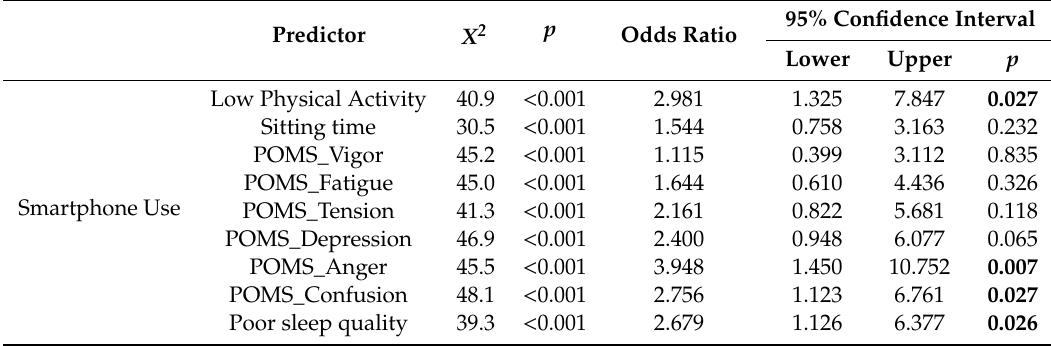
Table 3. Multiple logistic regression of probability of using the mobile smartphone (OR, 95% CI) with physical activity, sleep disturbance, and mood state. Predictor X 2 p Odds Ratio